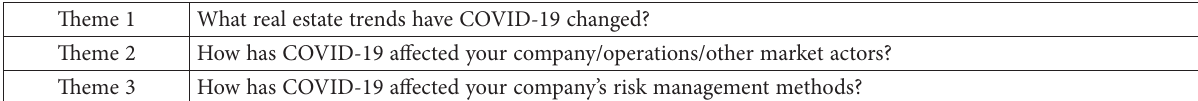
Table 2. Structure of the main interview themes